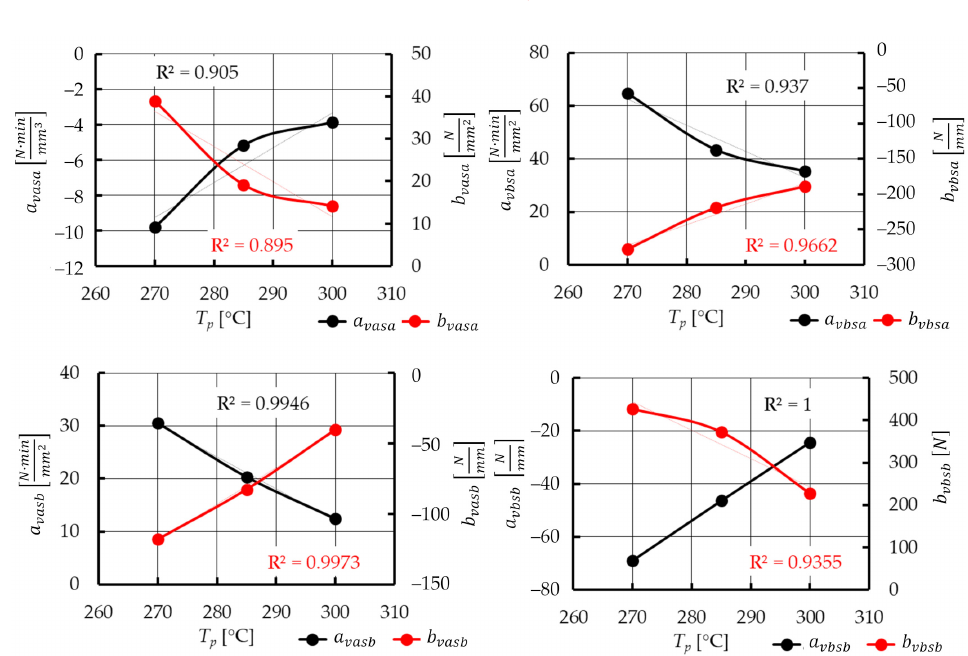
Figure 19. Exemplary correlation between the coefficients: a vasa , b vasa , a vbsa , b vbsa , a vasb , b vasb , a vbsb , and b vbsb and the temperature of the hot plate T p for the belt with diameter of 12 mm, plasticized with velocity v pl = 10 mm/min.